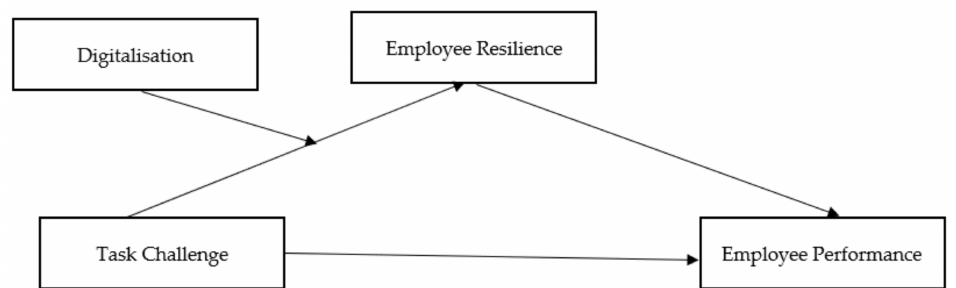
Figure 1. A conceptual framework for employee